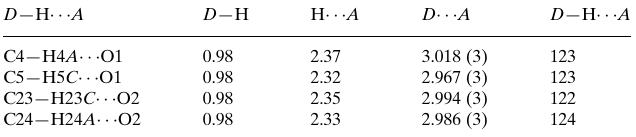
Hydrogen-bond geometry (A˚ , (cid:3)